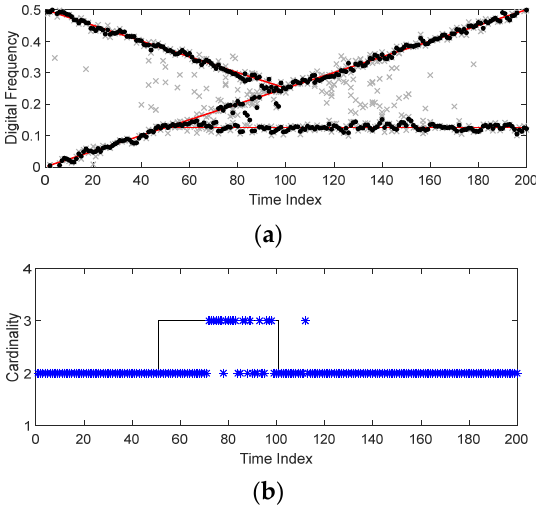
Figure 10. The result of the CC_CPHD (case 2): ( a ) Frequency tracking; ( b ) Cardinality estimate.